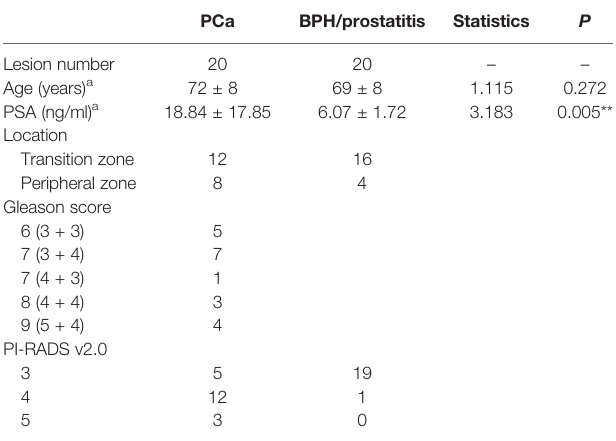
TABLE 1 | Summary of clinical and pathologic characteristics of